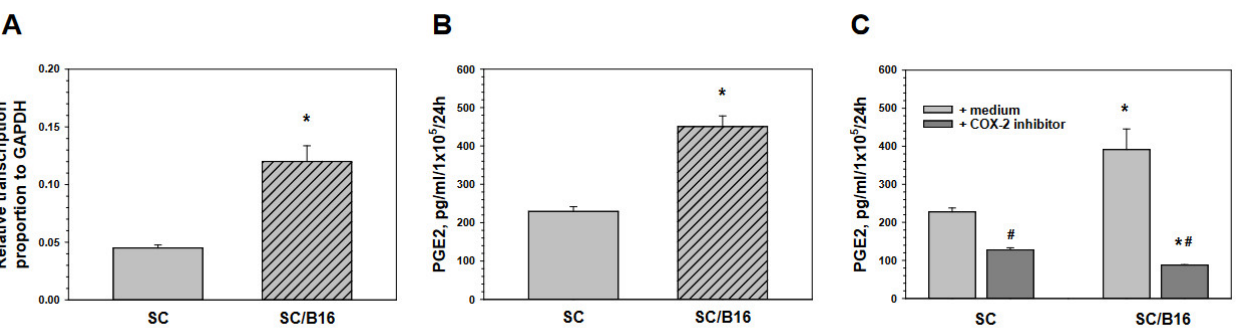
Figure 2. Malignant cells activated Schwann cells for PGE2 production. Adult SC were isolated from the sciatic nerve of C57BL/6 mice, cultured and purified as described in M&M. SC were then co-cultured with medium (SC) or with B16- conditioned medium (10% v / v ) (SC/B16) for 24 h and washed. Control and tumor-treated SC were then assessed for COX- 2 mRNA expression by qPCR ( A ) or cultured for another 24 h for measuring PGE2 production by ELISA ( B ). COX-2 inhibitor CAS181696-33-3 (10 μM, 24 h) prevented tumor-induced up-regulation of PGE2 expression in SC ( C ). Results are the mean ± SEM. *, p < 0.001 versus control SC group; #, p < 0.001 versus medium group (n = 3, Student t -test).